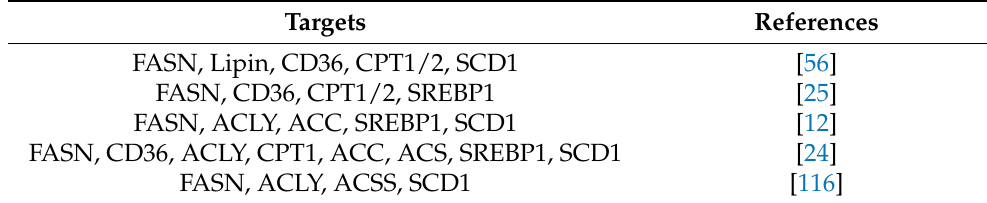
Table 1. List of lipid enzymes and fatty acid transport proteins that are targeted by single agents or in combination with therapeutics for the treatment of